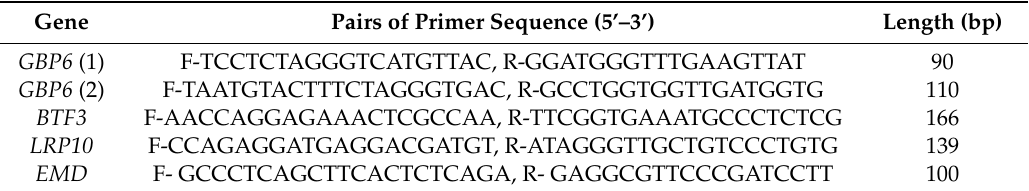
Figure 2. Two primers designed for quantitative polymerase chain reaction (qPCR) amplification on the gene structure of GBP6 . Table 1. Designed primers for real-time quantitative polymerase chain reaction (RT-qPCR) and qPCR based on Bos taurus genome of Bos_taurus_UMD_3.1 version.